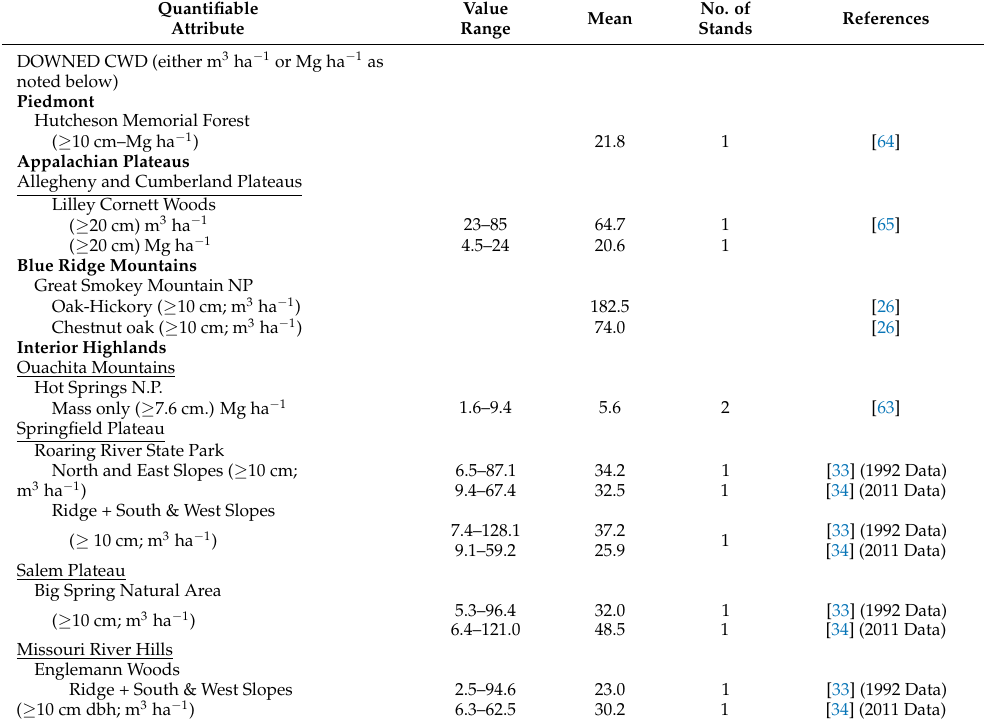
Table 7. Downed coarse woody debris (either m 3 ha − 1 or Mg ha − 1 as noted below) of representative dry-mesic old-growth oak